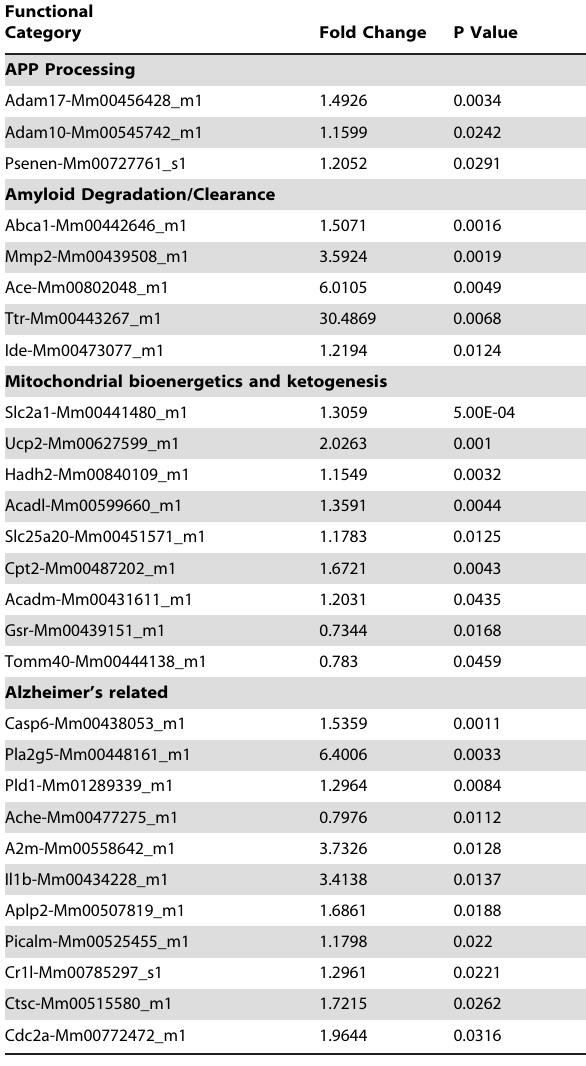
RNA samples isolated from hippocampal tissues of both the Ctrl and 2-DG groups were analyzed for gene expression with LDA mouse Alzheimer’s and customized mitochondrial array. Genes that were significantly regulated by 2- DG (P , 0.05 compared to Ctrl) were categorized into 4 different functional groups: APP processing; amyloid degradation and clearance; ketogenesis and mitochondrial function; and Alzheimer’s related. Data is presented as fold change relative to the Ctrl group with the corresponding p value listed for each individual expression did not change with 2-DG treatment (Fig. 6A), the immunoreactive distribution of Arc changed from a randomly scattered pattern of distribution to a clustered organization within neuronal processes (Fig. 6B, indicated by the arrows). The clustered distribution of Arc is suggestive of association with the translational machinery within neural processes, which has been observed in multiple models of learning of memory and induced by BNDF [32,33].